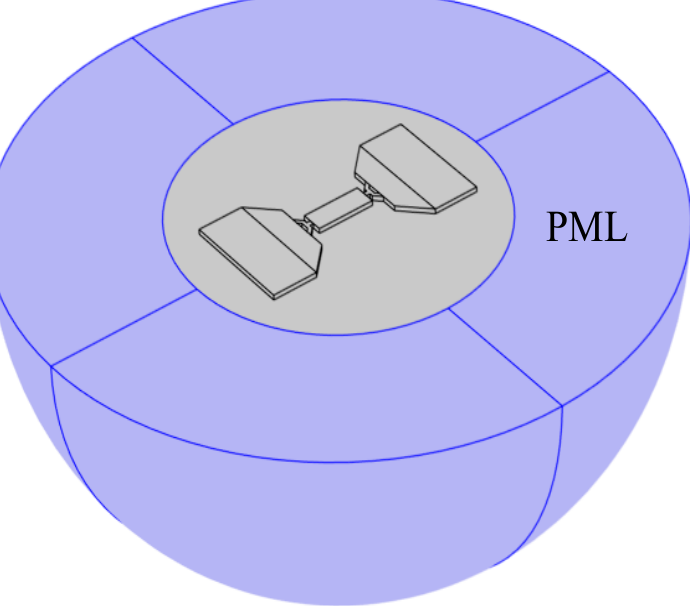
Figure 5. Comsol simulation of Q anchor with PML.